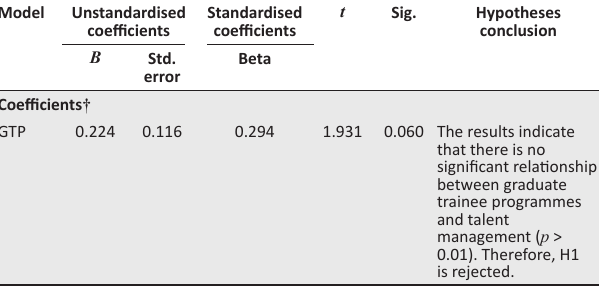
TABLE 2: Regression analysis for hypotheses